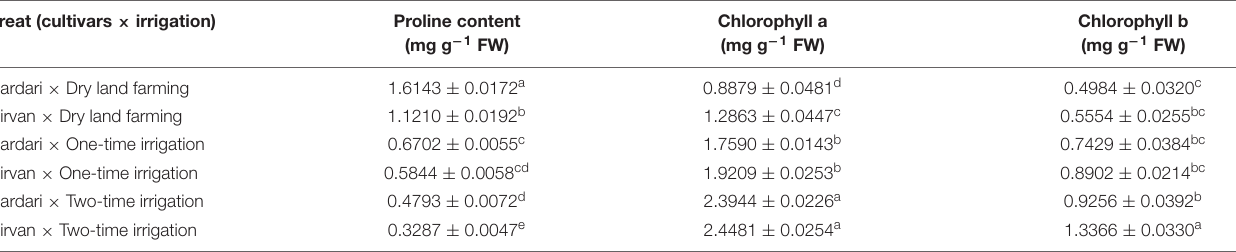
TABLE 8 | Mean comparisons of the dual interactions of irrigation and cultivars on some traits in wheat plant in 2018–2019. Treat (cultivars × irrigation)